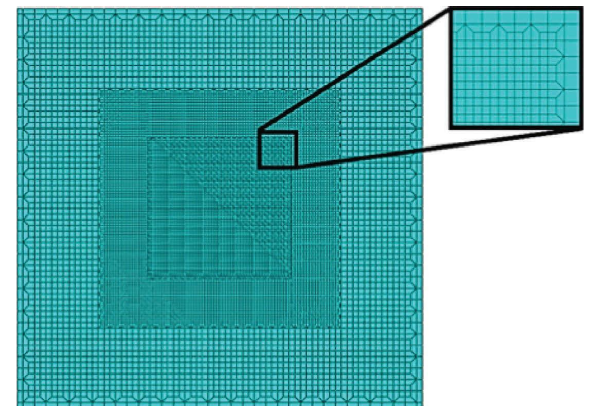
Figure 5: Te meshes of the sheet used in simulation.